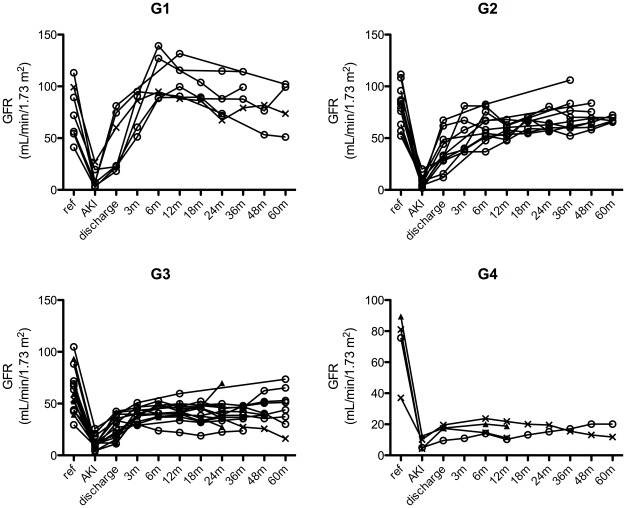
Comparison between reference and best GFR up to 18 months in all groups.GFR: estimated glomerular filtration rate.